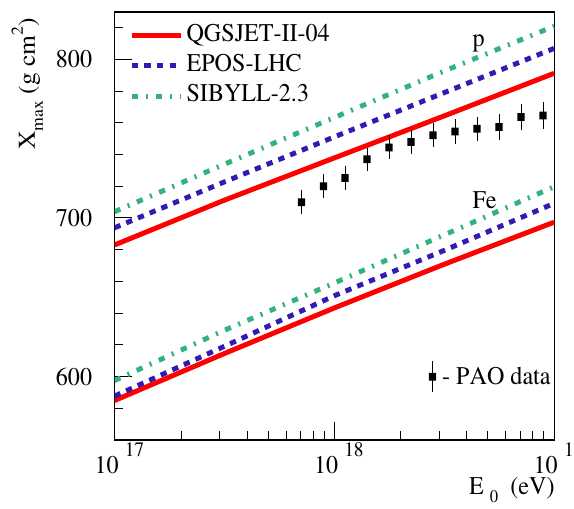
Figure 1. Primary energy dependence of the average shower maximum depth for proton- and iron-initiated vertical EAS, as calculated using the QGSJET-II-04 [17, 18], EPOS-LHC [14], and SIBYLL-2.3 [21] models (solid, dashed, and dashed-dotted lines respectively), compared to the data of the Pierre Auger Ob- servatory (PAO) [23] (squares).